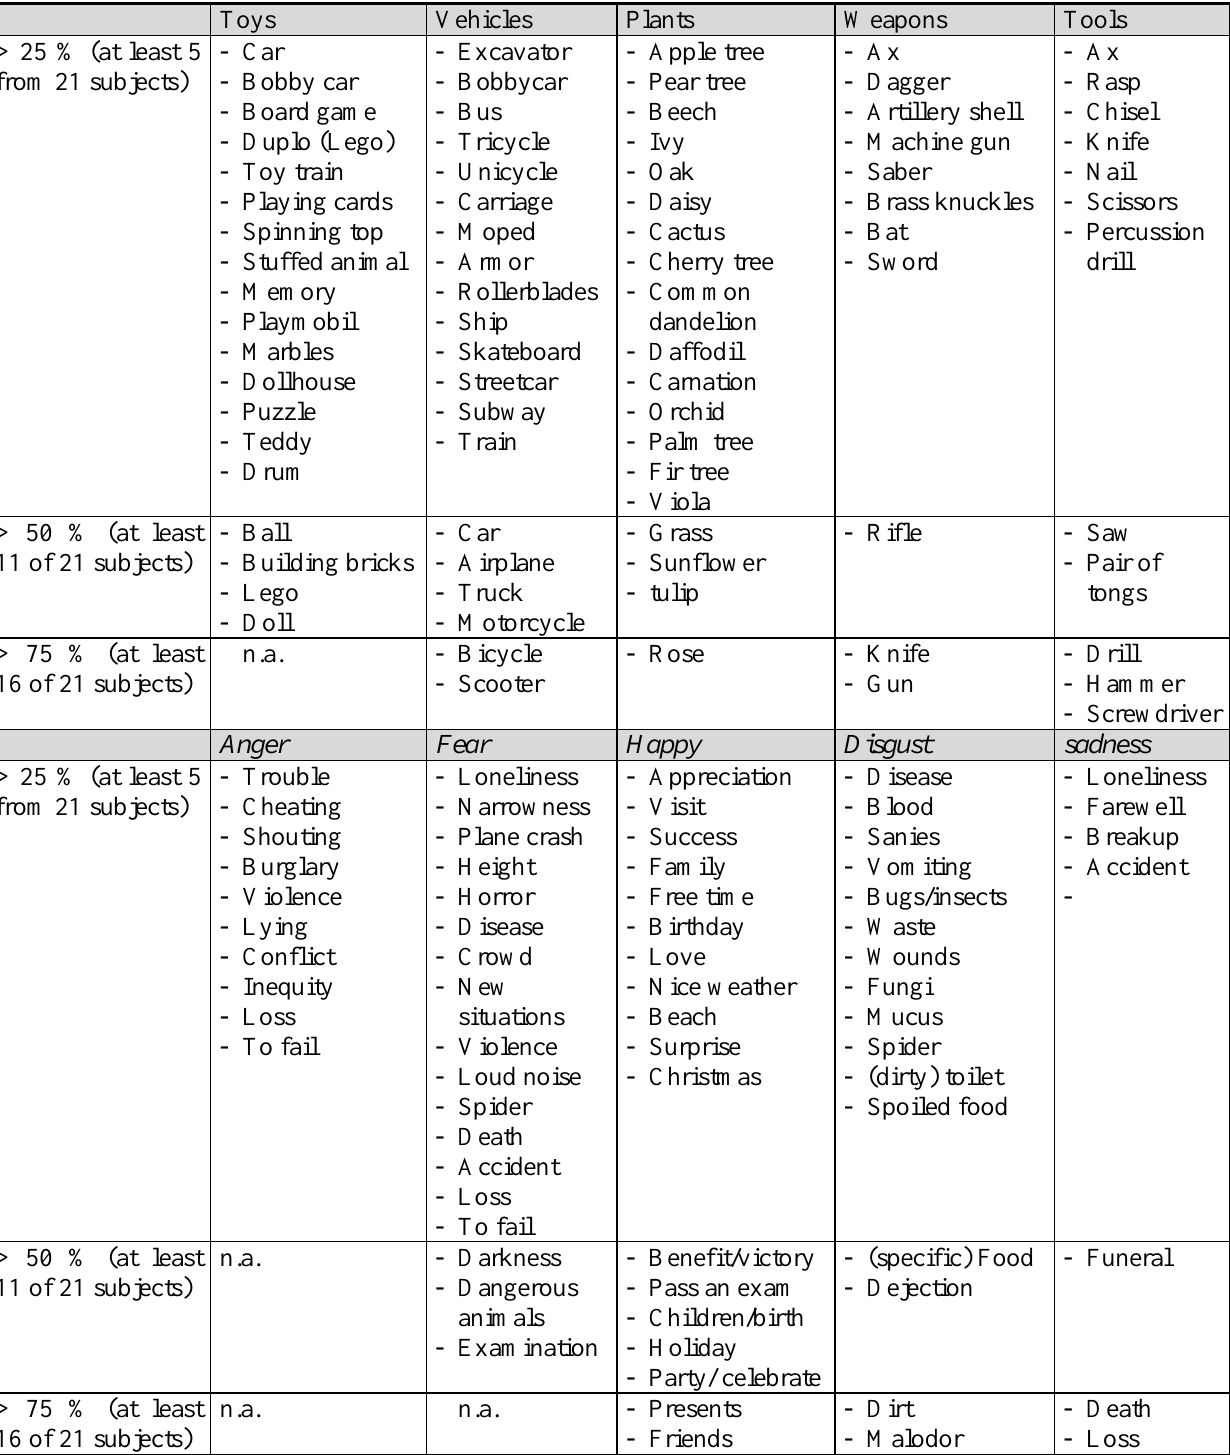
Table A1. Brief content analysis of produced